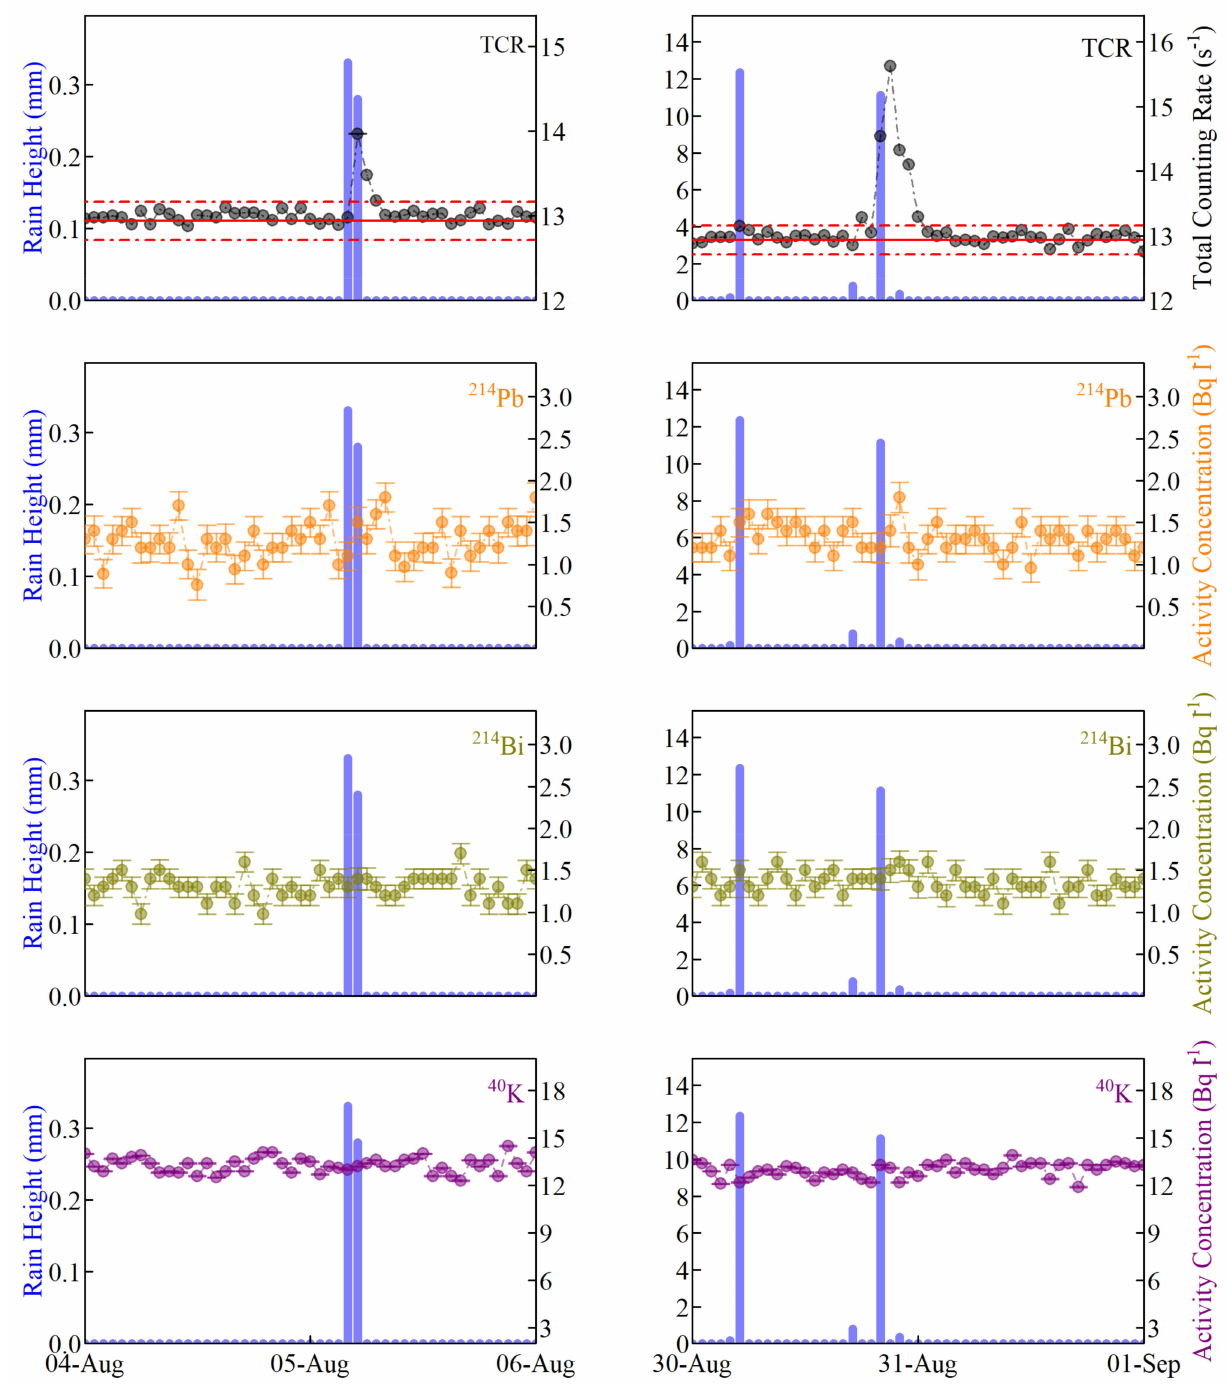
Figure A3. Representative rainfall events of August 2016. The y -axis of the first column regards rain height values (blue bars) while of the second TCR values, 214 Pb, 214 Bi and 40 K activity concentration (circular points). In the subplots of TCR, the mean value during dry meteorological periods is depicted as a red solid line, and the range of the statistically significant criterion is depicted with red dotted